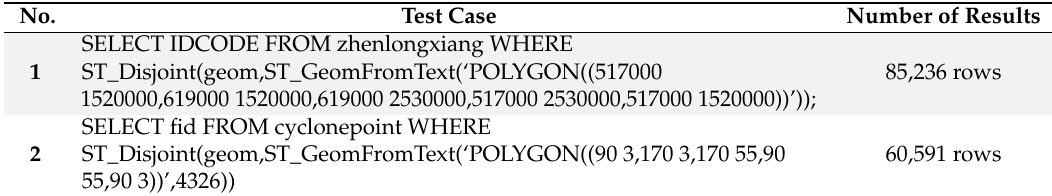
Table 16. Test cases of topological queries.